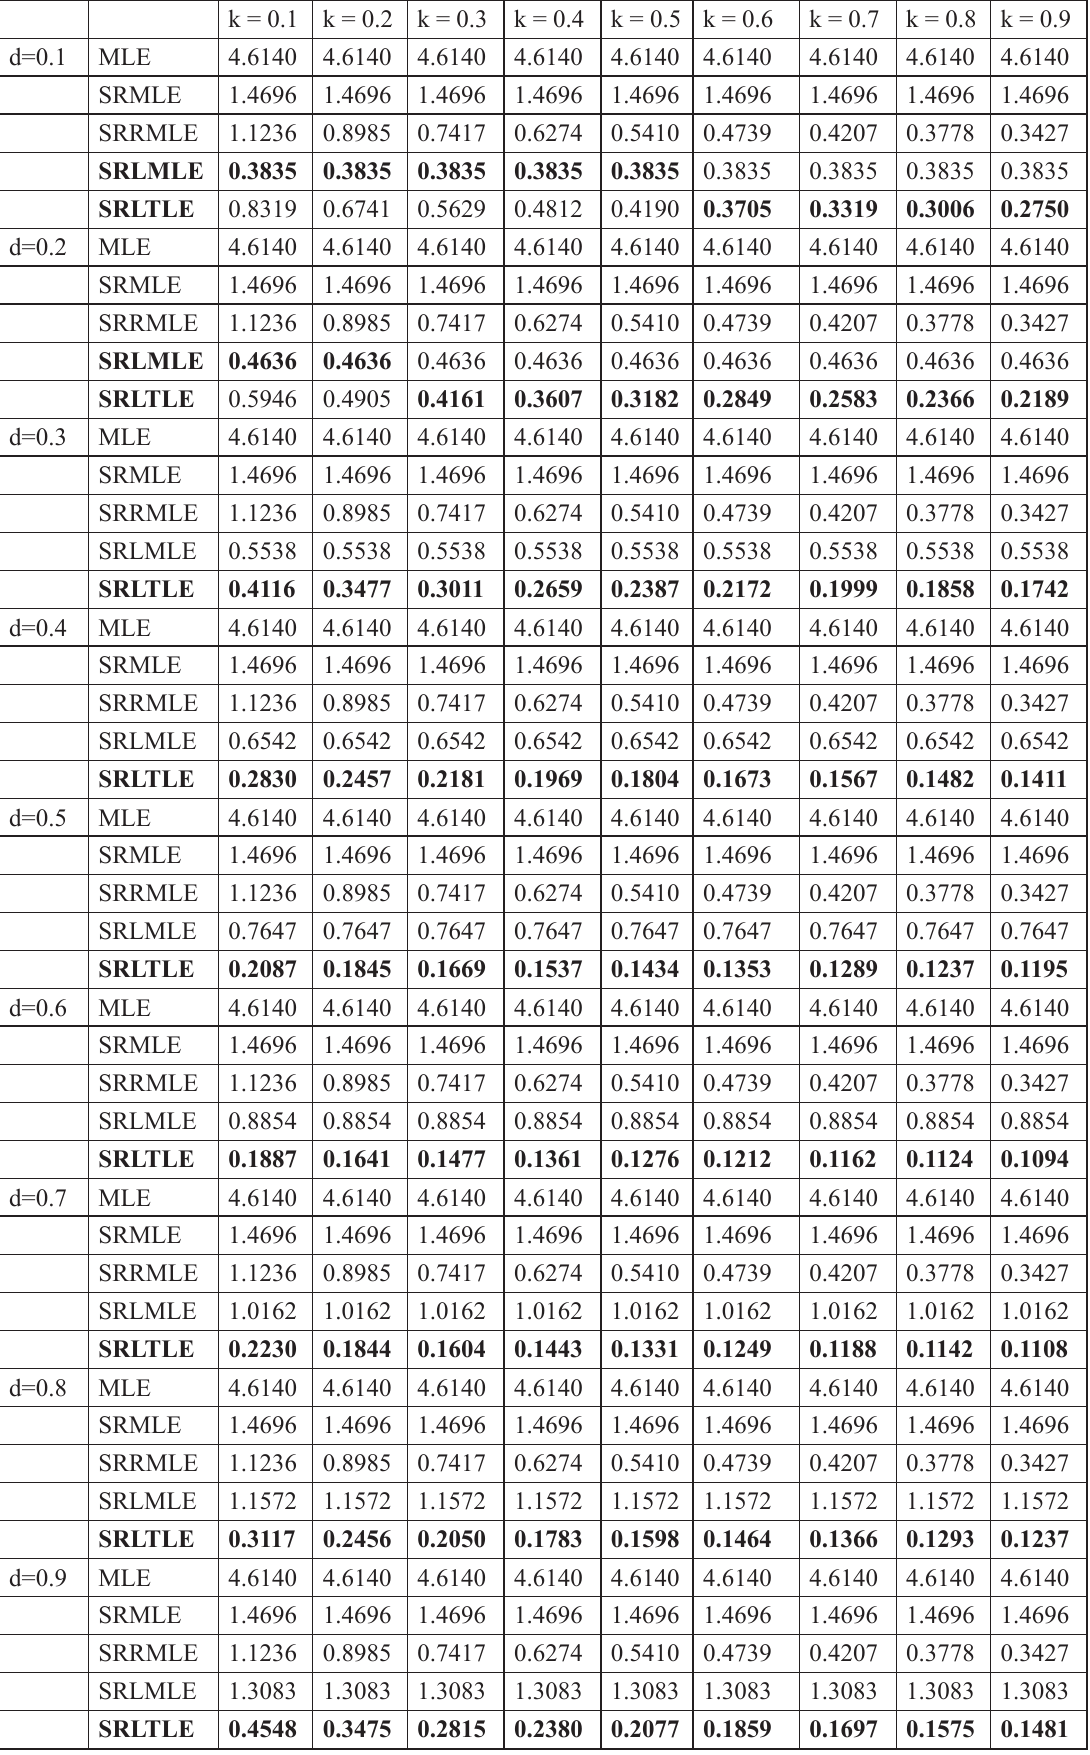
Table A3: The estimated MSE values for different dk , when n =50,